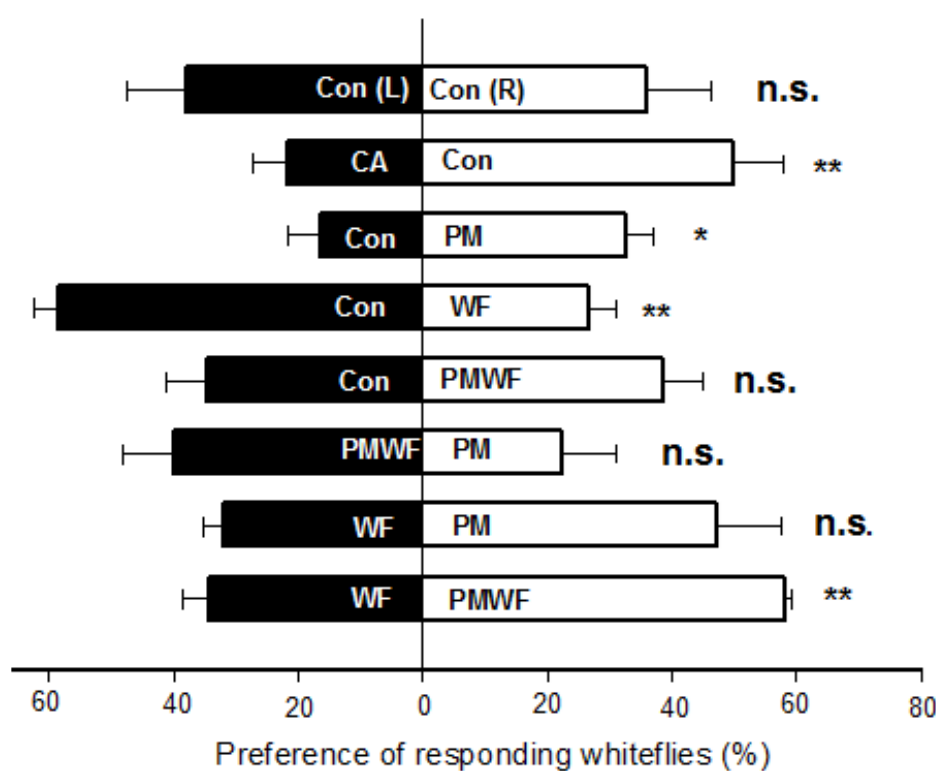
Figure 1. Preference of T. vaporariorum for the four treated plants ( CA , Clear Air; Con , Controls; PM , powdery mildew plants three days after inoculation; PMWF , powdery mildew plants three days after inoculation and infested by whiteflies for 24 h; WF , healthy plants infested by whiteflies for 24 h). There were 50 replicates for each treatment. The bars indicate the percentage of response/preference in the Y-tube olfactometer test (* p < 0.05 and ** p < 0.01 according to the Bonferroni paired t -test) (n = 50). Error bars represent standard errors and asterisks and n.s. indicates the significance level with n.s. = not significant.